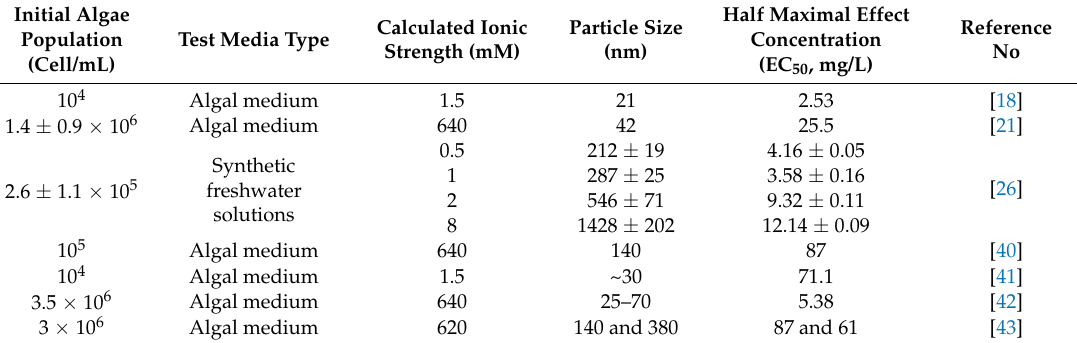
Table 1. Data on ecotoxic effects of TiO 2 nanoparticles on Raphidocelis